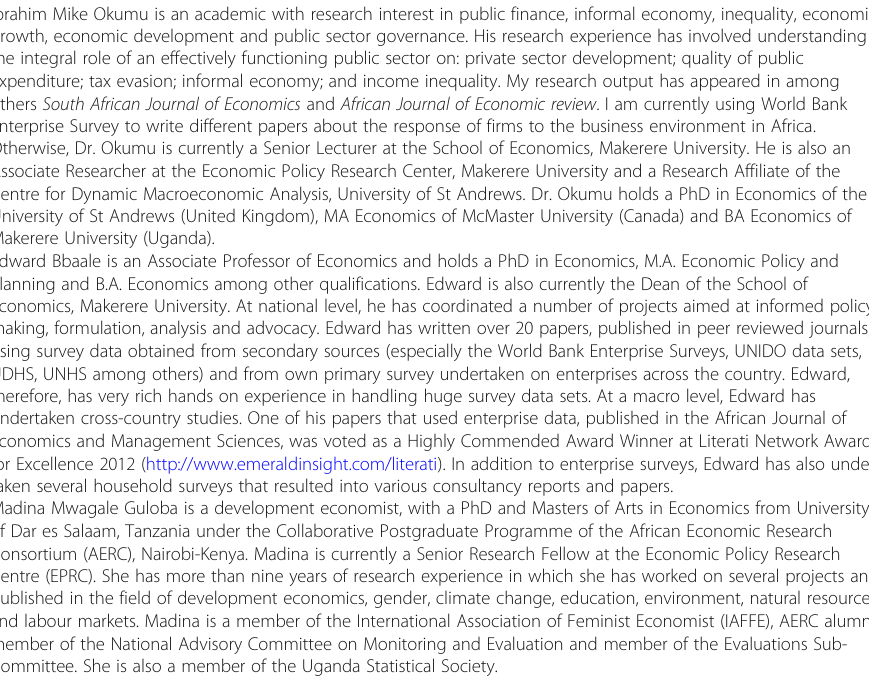
Abbreviations IV 2SLS: Instrumental variable two-stage least squares; MENA: Middle East and North African; OLS: Ordinary least squares; R&D: Research and development; SSA: Sub-Saharan Africa; SYS GMM: System generalized method of moments; WBES: World Bank Enterprise